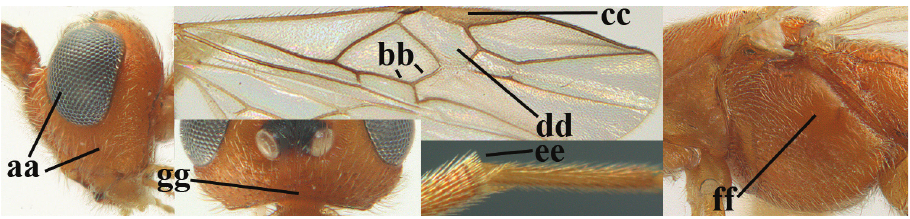
15 Fourth metasomal tergite curved posteriorly in dorsal view (a) and following tergites more or less retracted (b); vein r of fore wing 0.6–0.8 × vein 3-SR (c), precoxal sulcus largely granulate or coriaceous (d); trochanters, trochan- telli and pterostigma largely black(ish) (e); [vein m-cu of hind wing distinct; formerly Tetrasphaeropyx Ashmead, 1889. Associated with Macariini (Geom- etridae)] .................................................................................................... 16